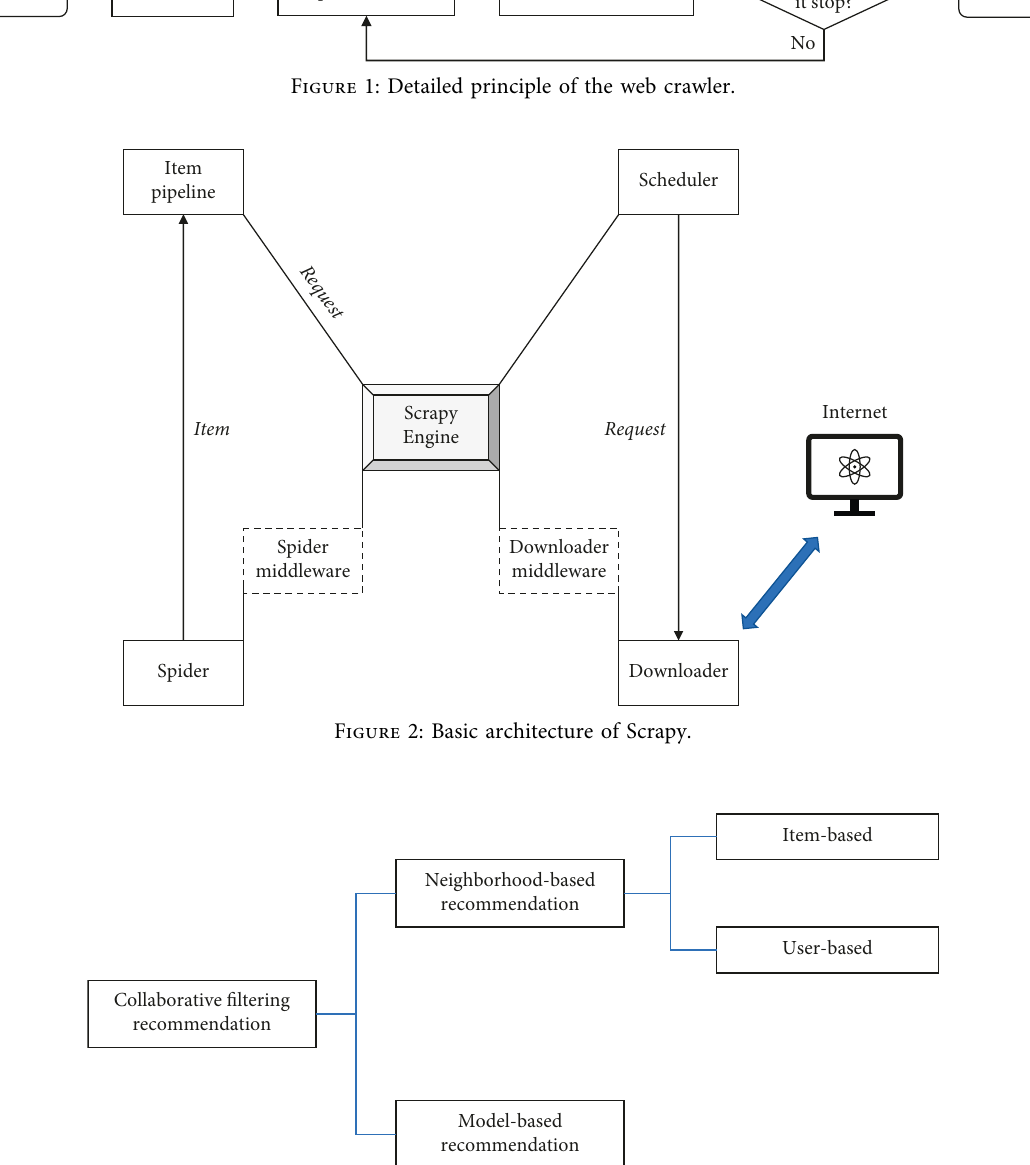
Figure 3: Category of collaborative filtering